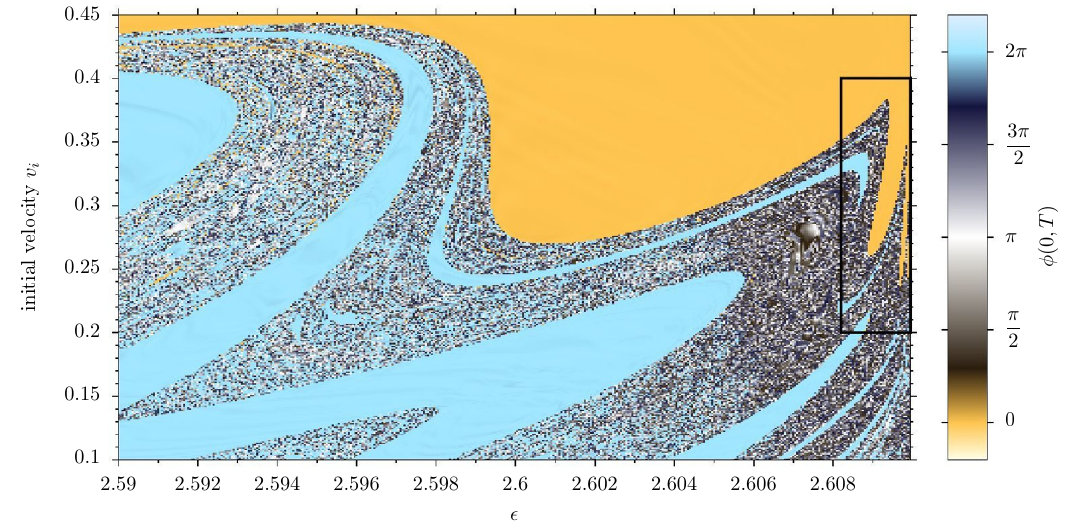
Figure 20 . The post-collision value of the field at the collision centre as a function of initial velocity of the colliding kinks, and the deformation parameter (cid:15) near the critical value. The field value was measured 300 units of time after the intersection of the initial trajectories, that is 300 + x 0 /v i units of time after the start of the simulation. The black rectangle to the right indicates the near-critical region plotted in figure